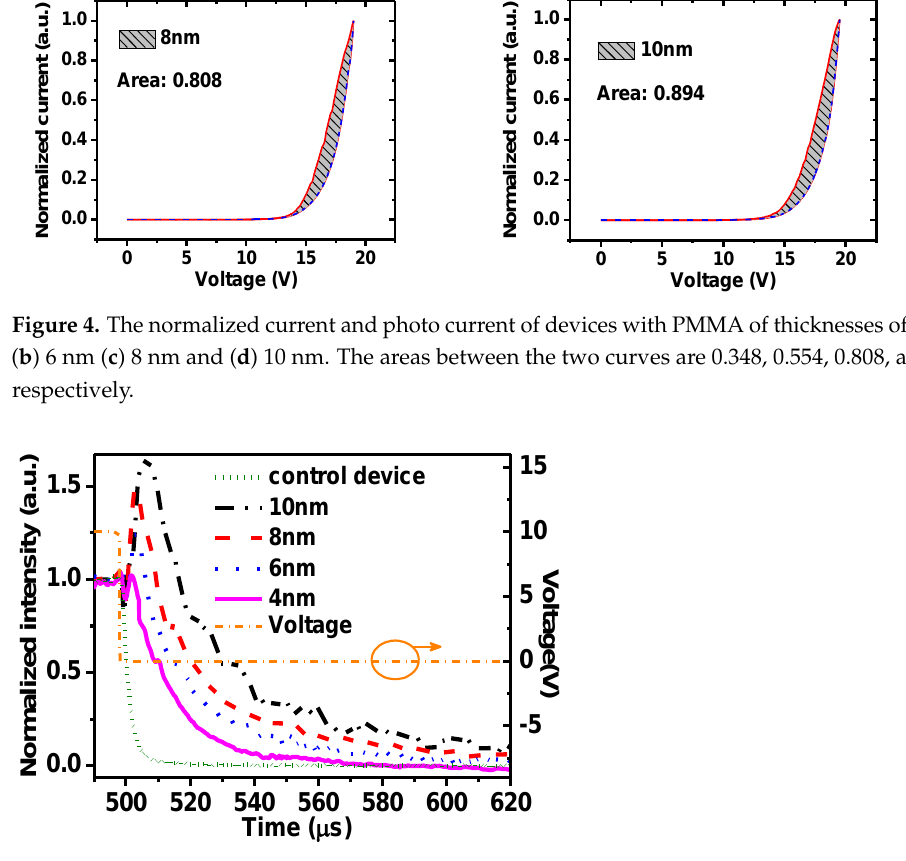
Figure 5. Transient EL measurements of all devices by applying a driving pulse of 10 V, 500 μs.